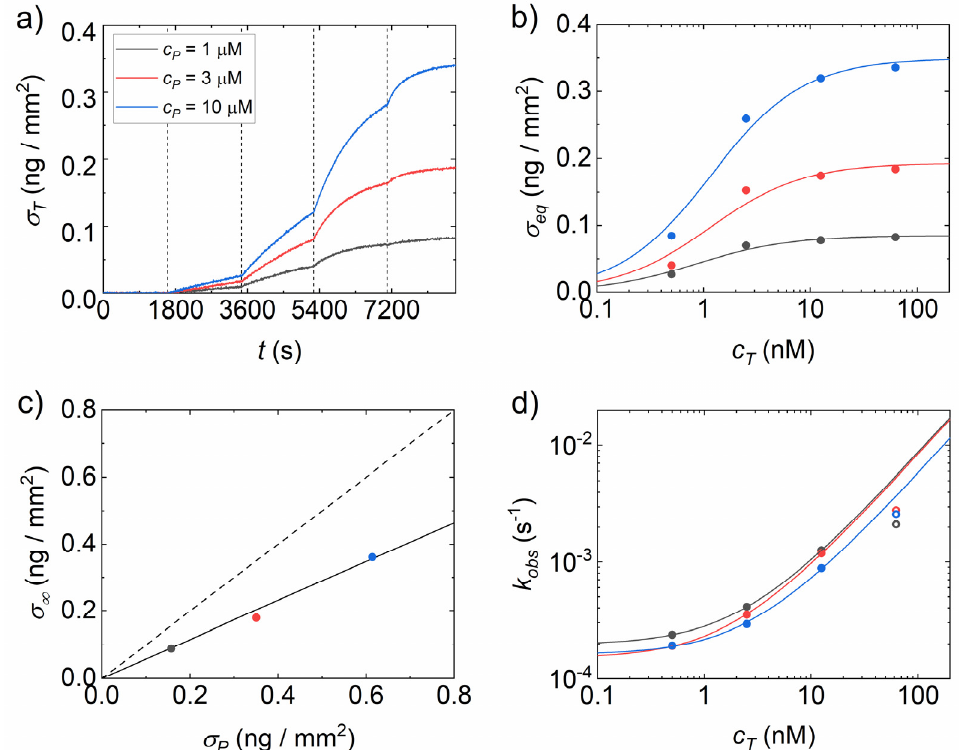
Figure 2. Analysis of RPI kinetic curves for DNA hybridization on MCP4 copolymer. ( a ) Binding curves for spots with three different DNA spotting concentrations: 1, 3 and 10 µ M shown in grey, red and blue colour, respectively. Vertical dashed lines represent the additions of target DNA strand to concentrations of 0.5, 2.5, 12.5 and 62 nM. ( b ) Equilibrium asymptotic amplitudes obtained from exponential fits to binding curves in panel a. Lines represent fits with Equation (3). ( c ) Saturation values of target surface density as a function of probe surface density. The dashed line represents the hybridization of all probe strands, i.e., yield of 100%. The continuous black line is a linear fit, from which the yield was calculated to be ~60%. ( d ) Observed kinetic rates obtained from the exponential fits of the hybridization curves are reported in panel A. Lines represent linear fits with Equation (4). The data points at the largest concentration are excluded from the fit applying a procedure described in [13]. In panel b, c and d, the color indicates the spotting concentration as in panel a.